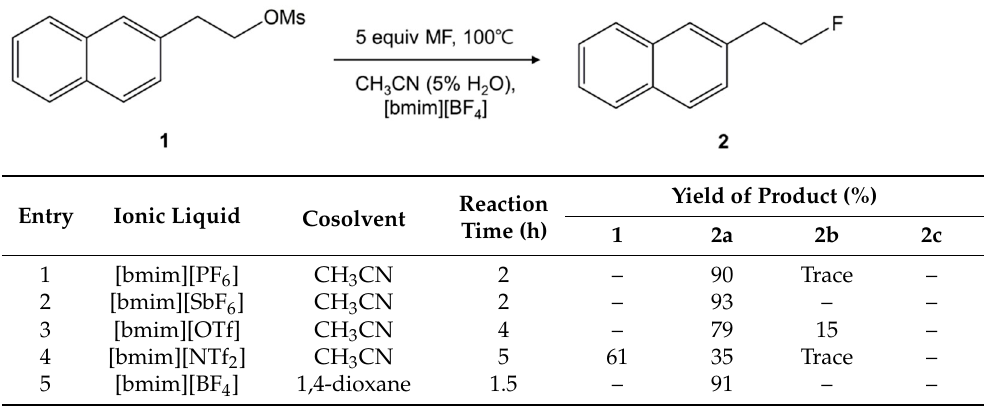
Table 2. Fluorination of mesylate 1 with KF in [bmim][BF 4 ] in various ionic liquids.